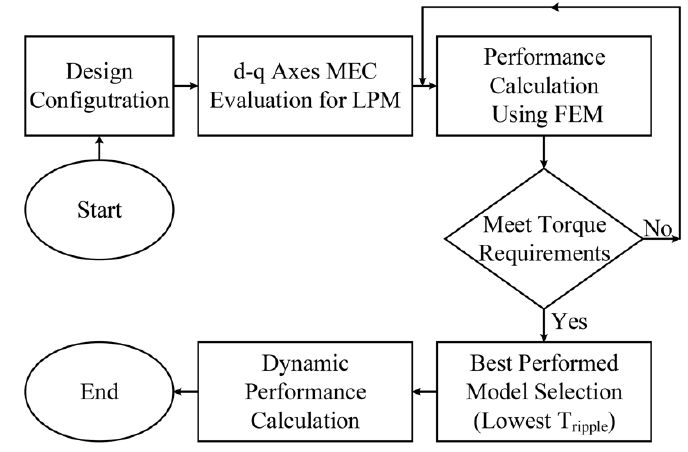
Figure 3. Winding: ( a ) Factor, ( b ) MMF.